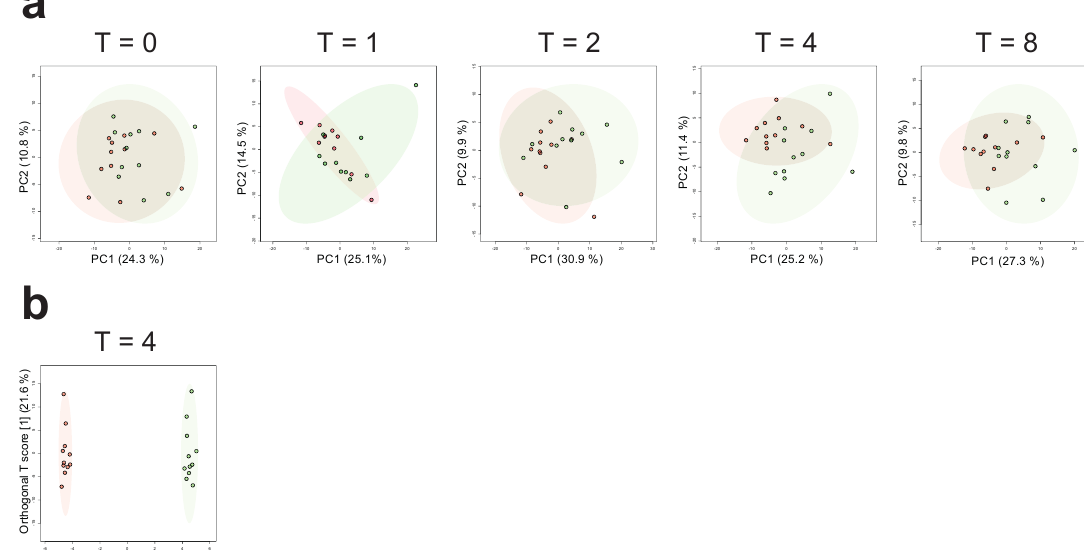
Figure 1. E ff ects of endotoxemia on the plasma metabolome. ( a ) Principal component analysis (PCA) of the plasma metabolome at T = 0 (just prior to lipopolysaccharide (LPS) administration), 1, 2, 4, and 8 h following LPS administration in the control group. The red dots indicate baseline (one hour before LPS administration) and the green dots are the timepoints, indicated above the graphs. The shaded areas indicate the 95% confidence intervals. ( b ) Orthogonal partial least squares-discriminant analysis (OPLS-DA) of the plasma metabolome at 4 h after LPS administration in the control group. The red dots indicate baseline (one hour before LPS administration) and the green dots indicate 4 h post-LPS administration. The shaded areas indicate the 95% confidence